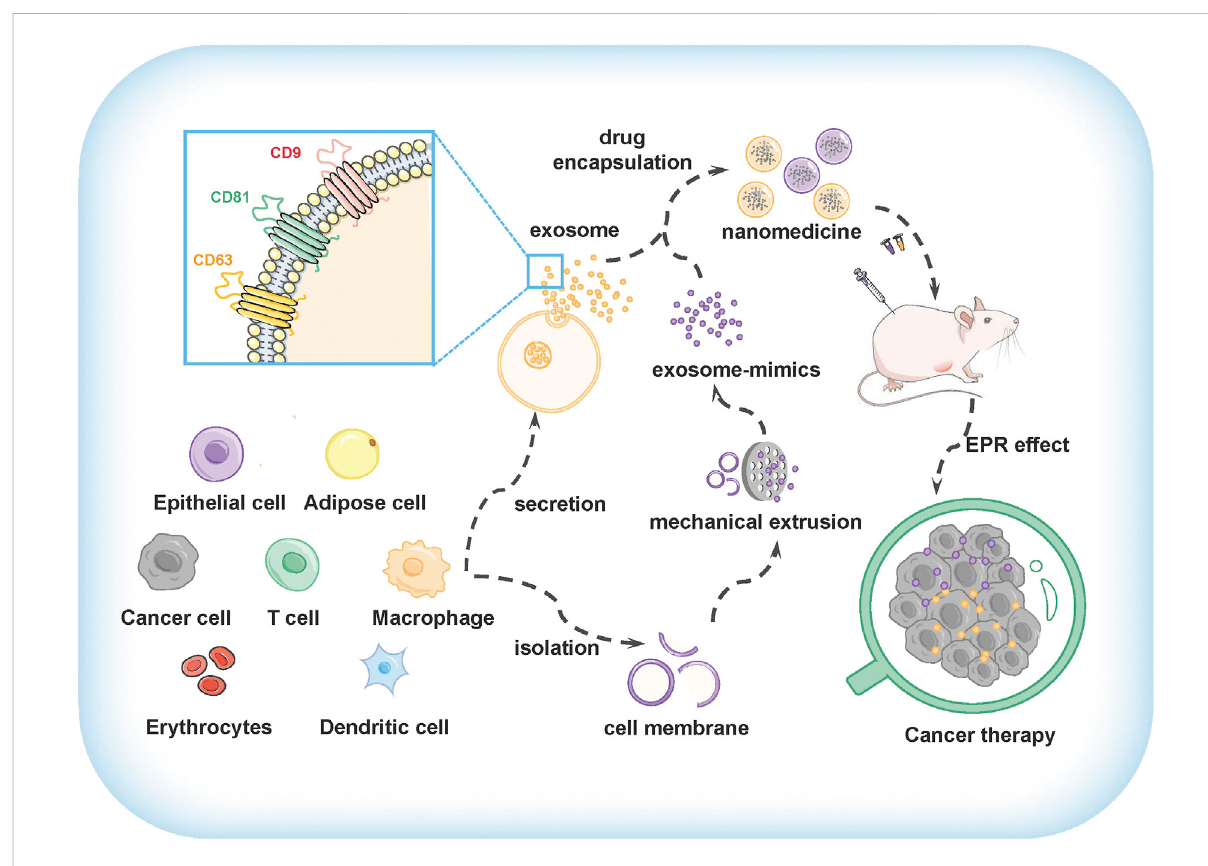
FIGURE 1 The preparation and application of exosomes and exosome-mimics as drug delivery vehicles for cancer